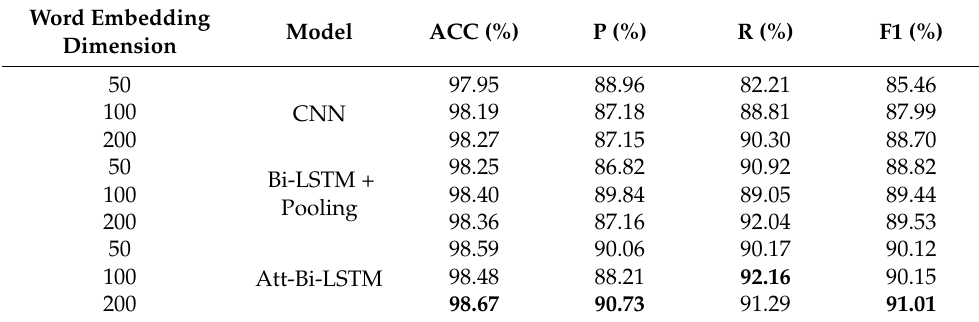
Table 7. The test results of the relation extraction